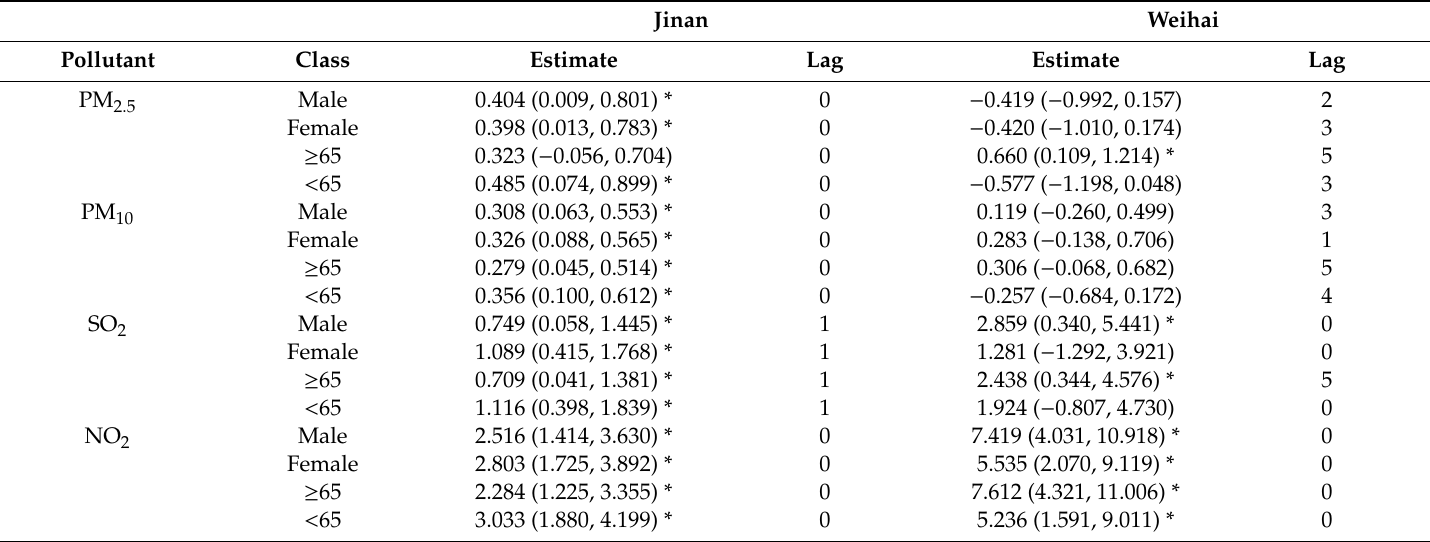
Table 3. The changes in the relative risk of cardiovascular disease hospitalizations for patients by gender and age, and their 95% confidence interval (CI) per 10 µ g / m 3 increase in air pollutants in Jinan and Weihai, where * indicates statistically significant estimates ( p <